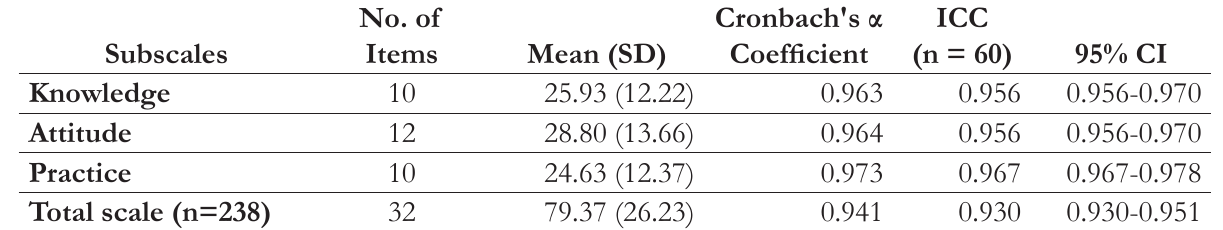
Table 3. Cronbach’s α Coefficient and ICC for the entire KAP Scale and its Subscales (n =